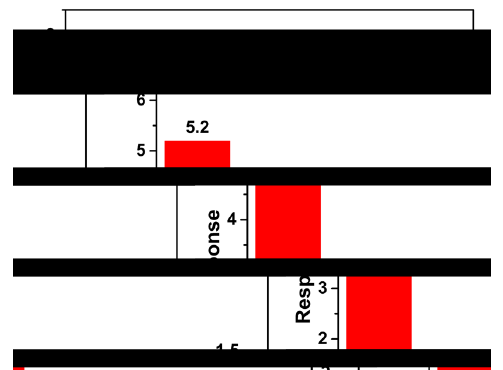
Fig. 7 Responses of WO 3 nanomesh sensor to NO 2 (500 ppb) and other several gas species such as C 2 H 6 O (10 ppm), NH 3 (10 ppm), CO (50 ppm), and H 2 S (5 ppm) at 160 ℃ .